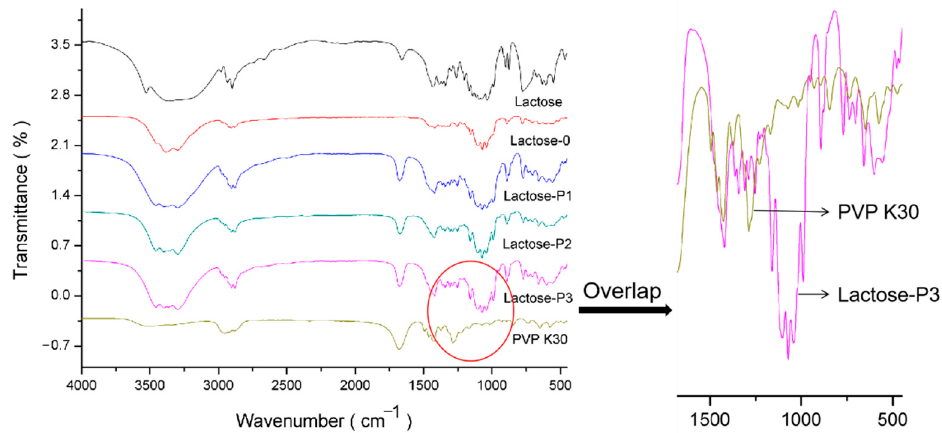
Figure 3. The FTIR of materials. Lactose, the raw material; Lactose-0, processed without PVP K30; Lactose-P1, processed with 1% PVP K30; Lactose-P2, processed with 2% PVP K30; Lactose-P3, pro- with 1% PVP K30; Lactose-P2, processed with 2% PVP K30; Lactose-P3, processed with 3% PVP cessed with 3% PVP K30.